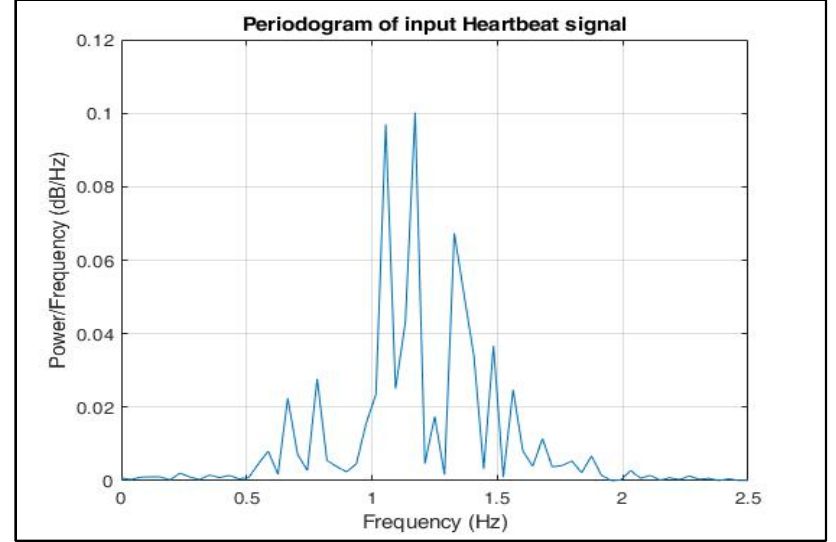
Figure 11. Periodogram of input heartbeat phase signal.